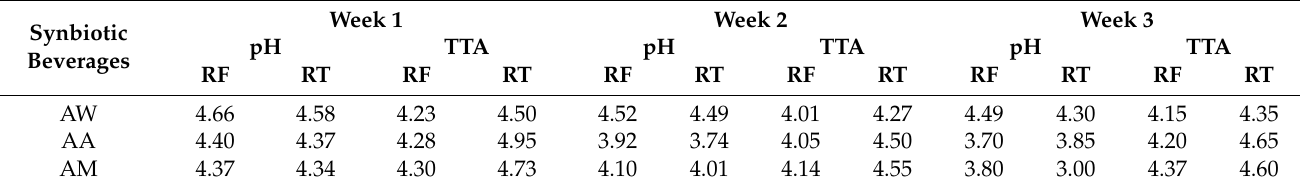
Table 9. Effect of storage on pH and titratable acidity of synbiotic beverages.